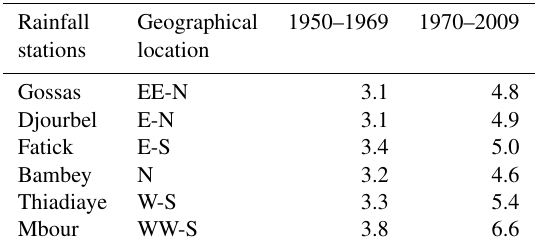
Table 3. Evolution of the coefficient of variation of the 6 stud- ied rainfall stations for the two homogeneous climatic period of 1950–1969 and 1970–2009 (the geographical location is qualified by North, South, East and West, related to the 2 studied watersheds of Sob and Diohine; example: Gossa station with EE-N is at the extreme East and the North of the studied